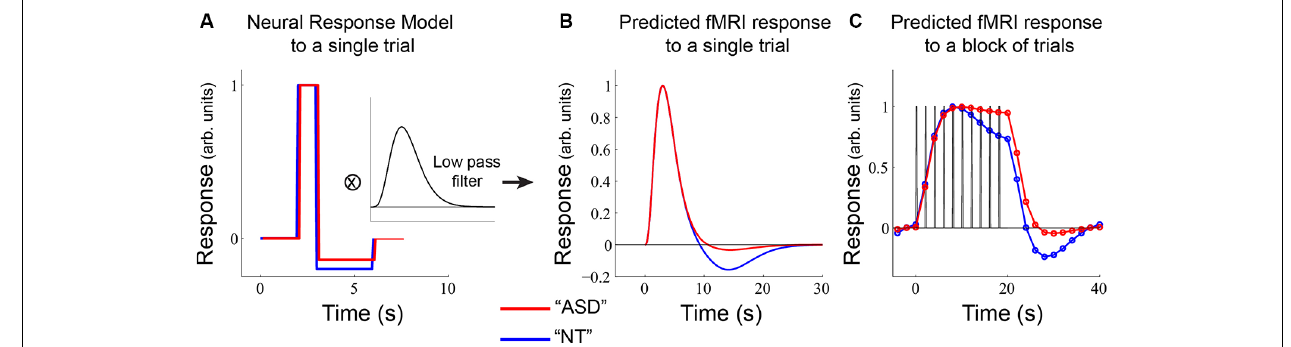
FIGURE 6 | A model of potential underlying differences in neural response in sensory-motor regions. (A) ASD and NT participants were modeled as having the same increase in neural response but differences in neural offset responses. This neural response was passed through a low-pass filter to obtain the predicted fMRI response to a single stimulus event (B) . (C) A predicted fMRI response was obtained by convolving the function in (B) with a block of 10 trials (as used in the main experiment).